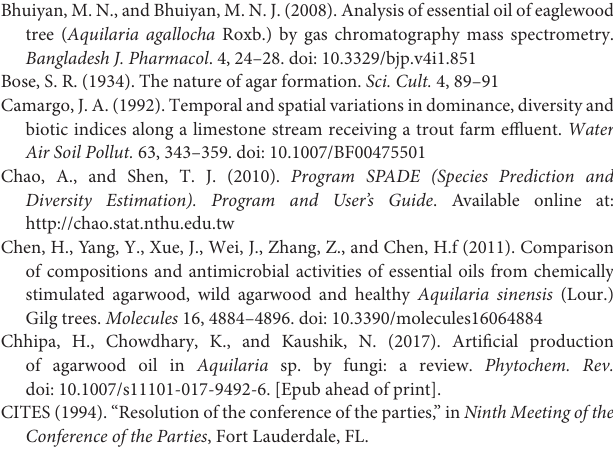
Figure S3 | F -test of significance for agarospirol content variation between fungal infected and control wood (A) , bacterial infected and control wood (B) and fungal and bacterial infected wood (C) . Figure S4 | Bi plot of GC data of bacterial and fungal infected wood samples collected 3 months after artificial inoculation Bacteria Fungi. Figure S5 | PCA plot of GC data of bacterial and fungal infected wood samples collected 3 months after artificial inoculation Bacteria Fungi. Table S1 | List of sample collected from different districts of Assam for microbial isolation. Table S2 | Identification of fungal and bacterial isolates on the basis of sequence similarity with different sequence data